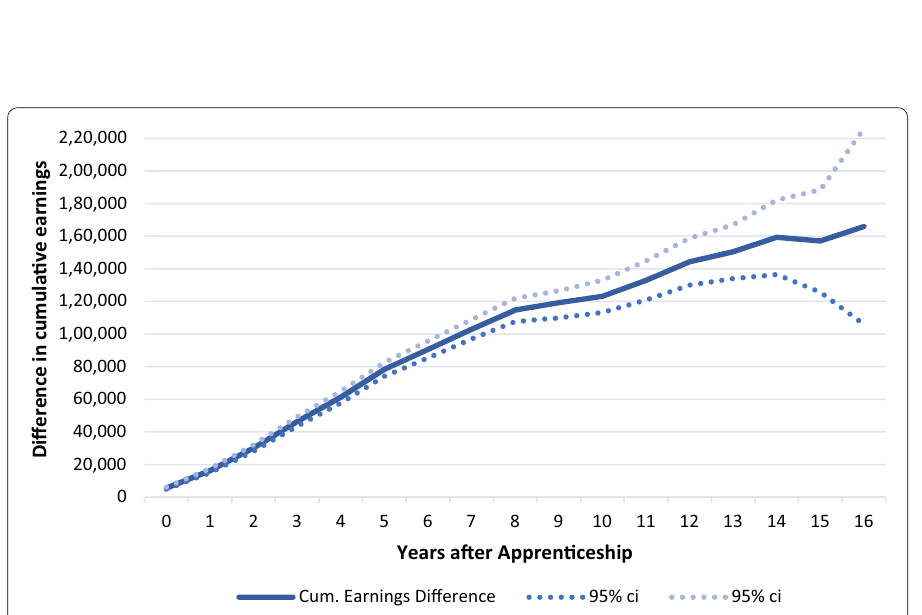
Fig. 7 Differences in cumulative earnings between matched foremen and university academics (N